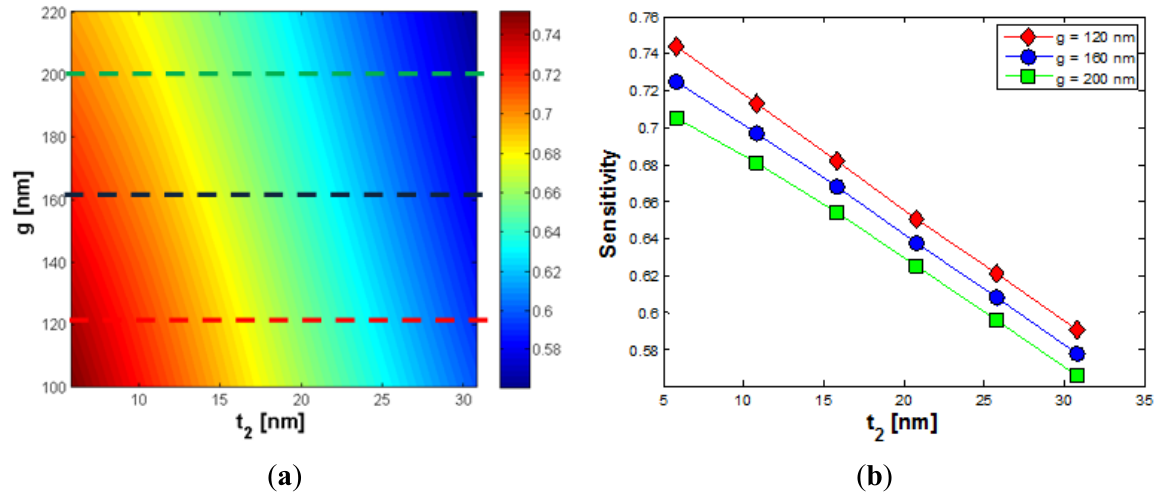
, when W = 220 nm, H = 220 nm and 2 for different values of g 2